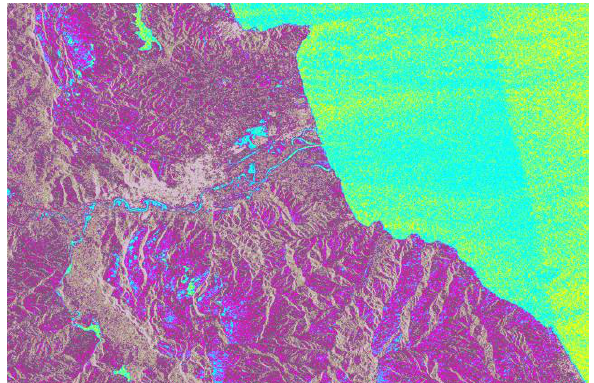
Figure 7. Results of Flooding are using S1 SAR